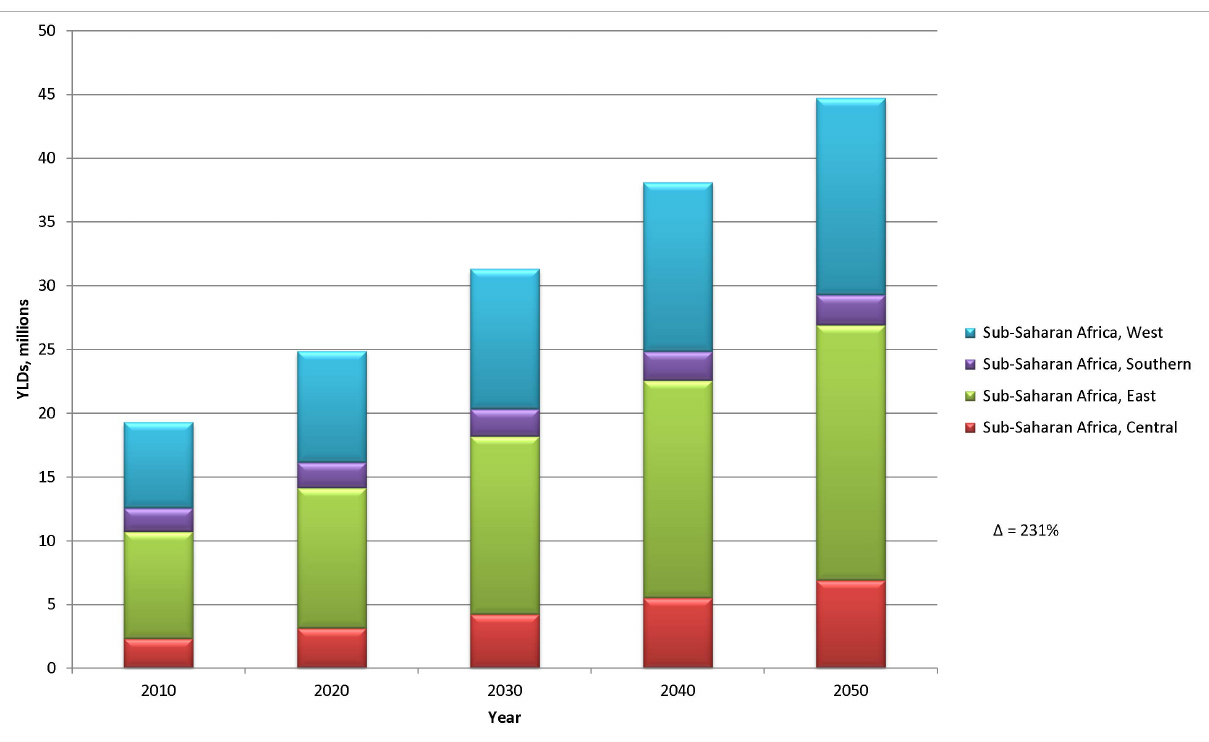
Figure 4. Disability burden of mental and substance use disorders in Sub-Saharan Africa over time, all ages.